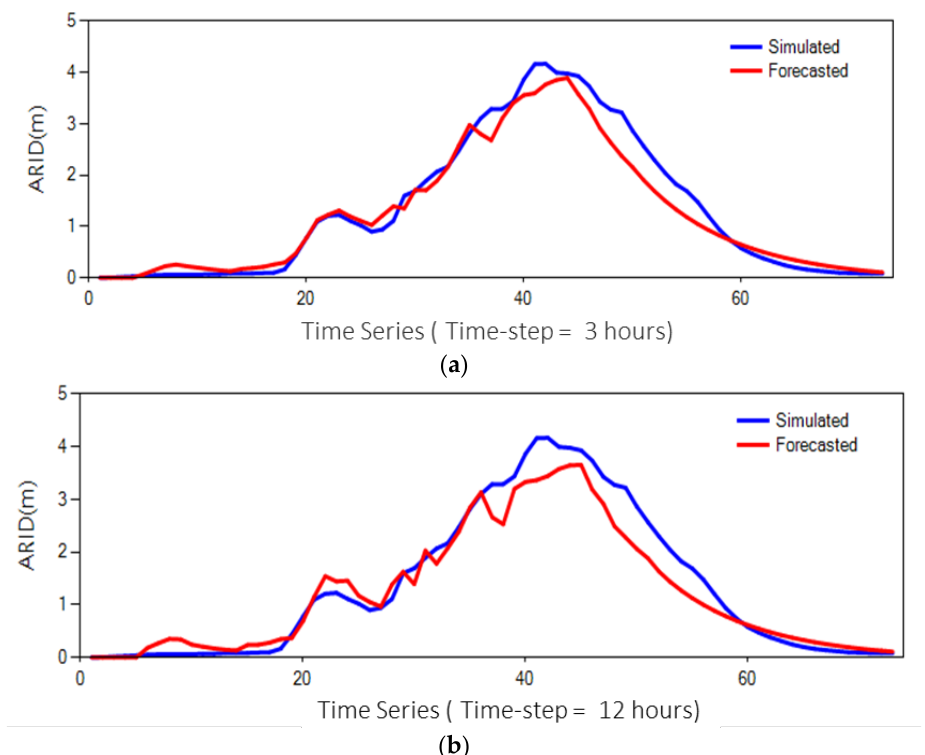
Figure 8. Simulated and forecasted ARIDs obtained from the RNARX model for Event 7. ( a ) 3 h-ahead simulated and forecasted ARIDs; ( b ) 12 h-ahead simulated and forecasted ARIDs.